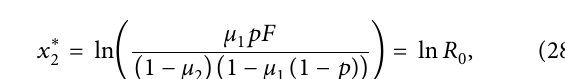
, μ ,p, F ) � ( 1 , 0 . 1 , 0 . 9 , 50 ) . 1 2